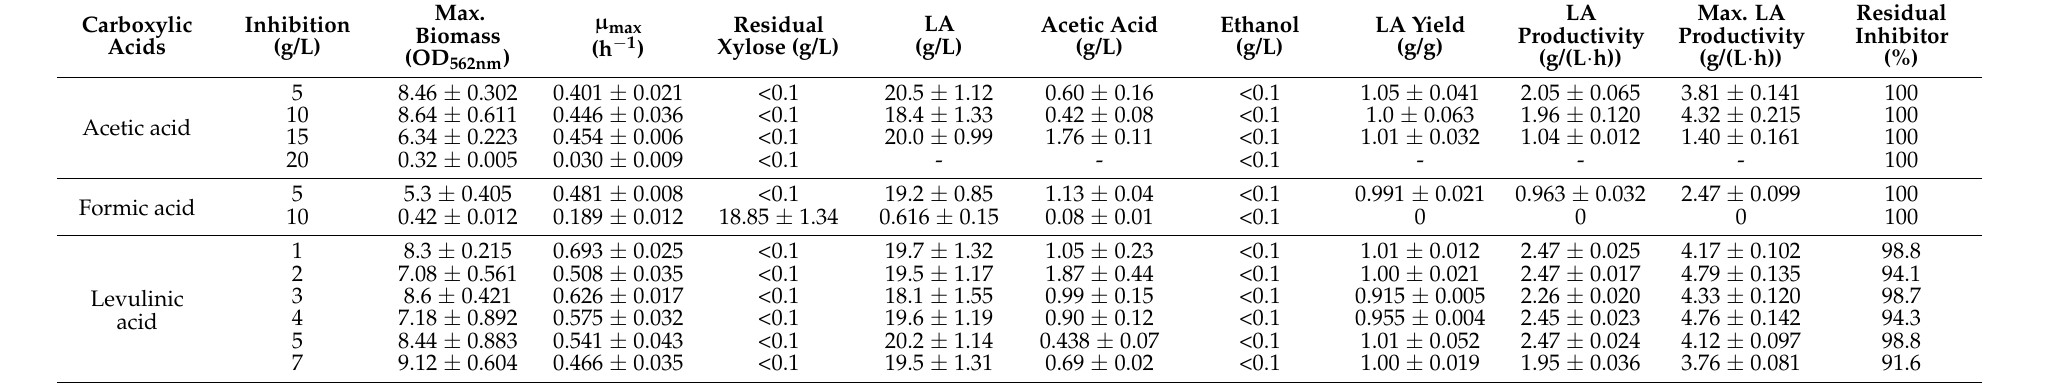
Table 3. Effect of carboxylic acid on lactic acid fermentation efficiency by Bacillus coagulans